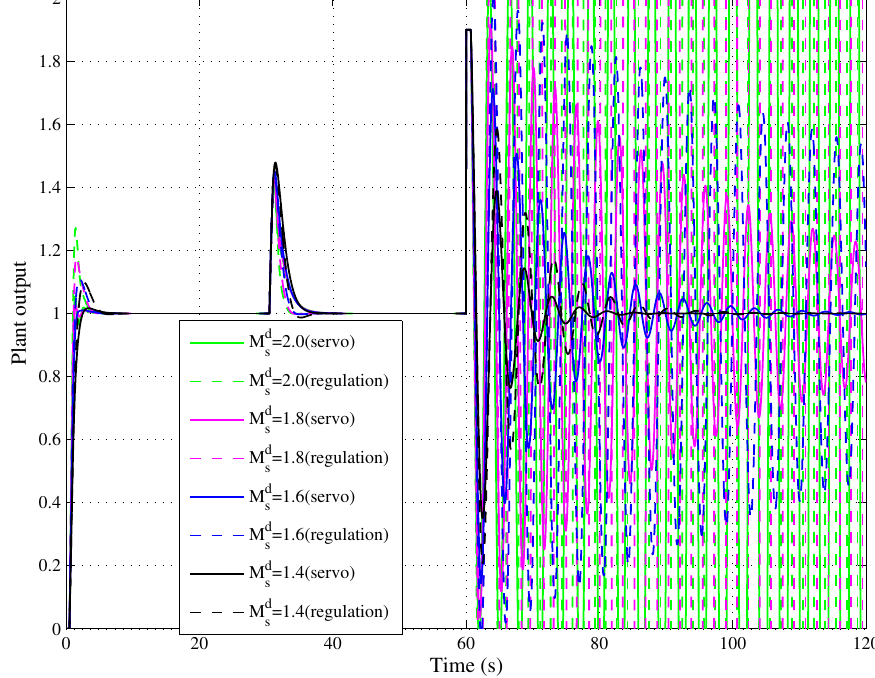
Figure 14. Model perturbation